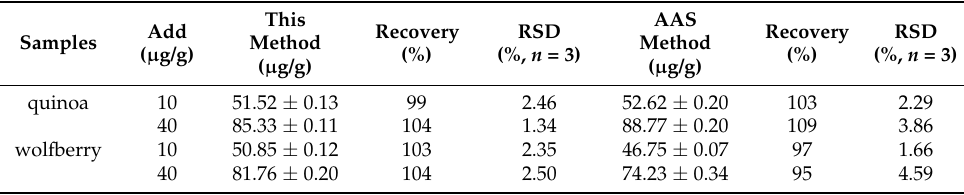
Table 5. Recovery of Ag + in different food samples ( n =